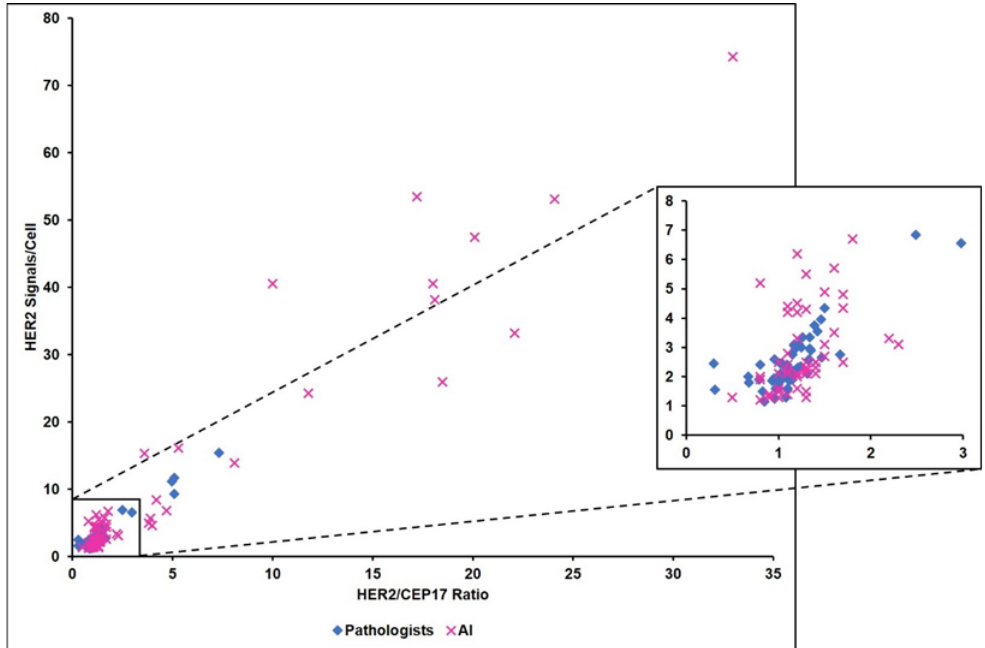
Figure 4. Comparison of the calculated HER2/CEP17 ratio and the HER2 signals/cell between Pathologists and AI-assisted DIA on the ISH-stained slides.